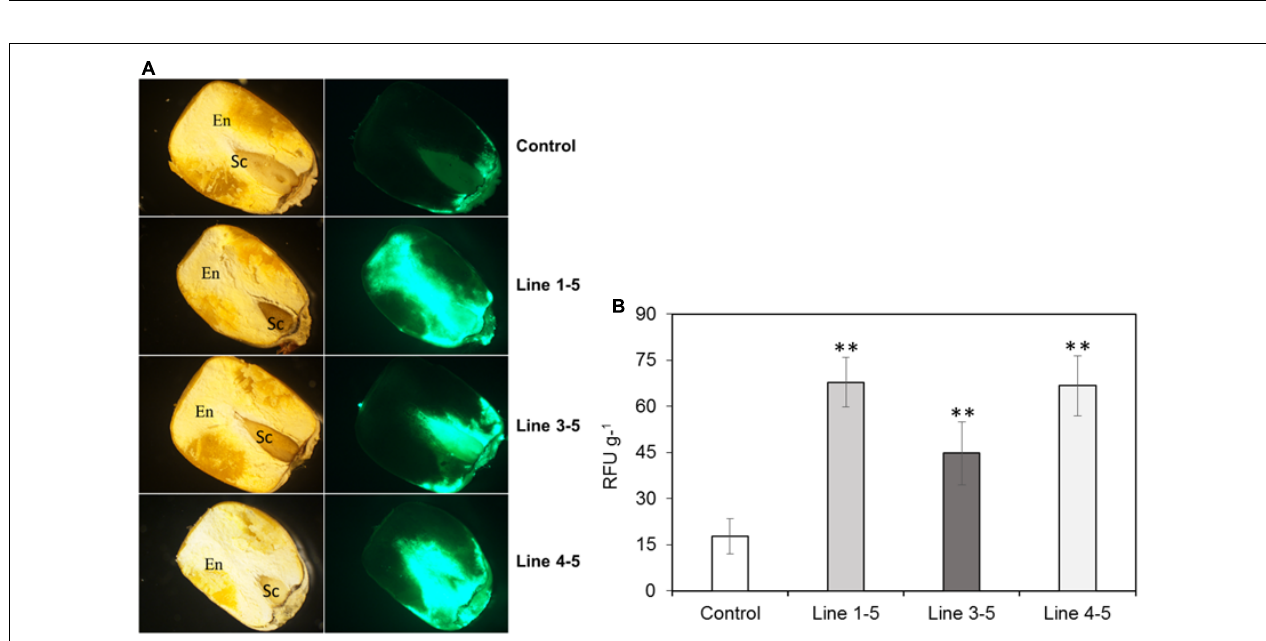
FIGURE 3 | Fungal growth in the T1 generation maize kernels. (A) Growth of A. flavus -GFP at 7 dpi (as indicated by relative GFP fluorescence; Rajasekaran et al., 2013) in empty vector transformed control and ZmPRms– RNAi transgenic maize kernels (First column: light micrographs and second column: GFP fluorescence micrographs of longitudinal sections of kernels. En: endosperm; Sc: scutellum); (B) Quantification of GFP fluorescence in the kernels of empty vector transformed control and ZmPRms– RNAi maize transgenic plants at 7 days post inoculation (dpi) with A. flavus . Relative fluorescence units (RFU) is directly proportional to fungal growth in the kernels. Data are mean ± SE of 5 biological replicates. ∗∗ Denotes significant difference between control and PRms silenced lines ( P ≤ 0.05).